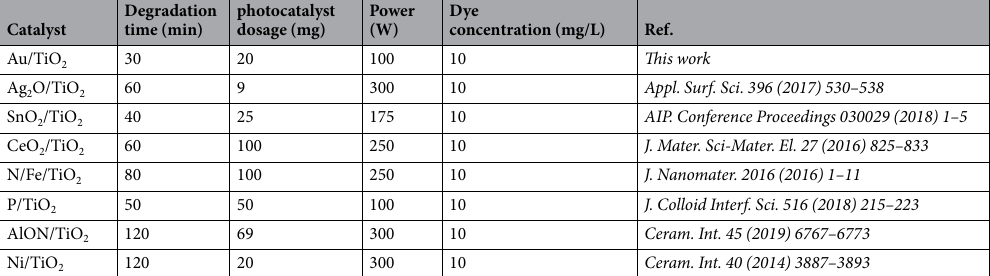
Table 2. Comparison of photocatalytic performance of Au/TiO 2 with other UV-activated photocatalysts under UV